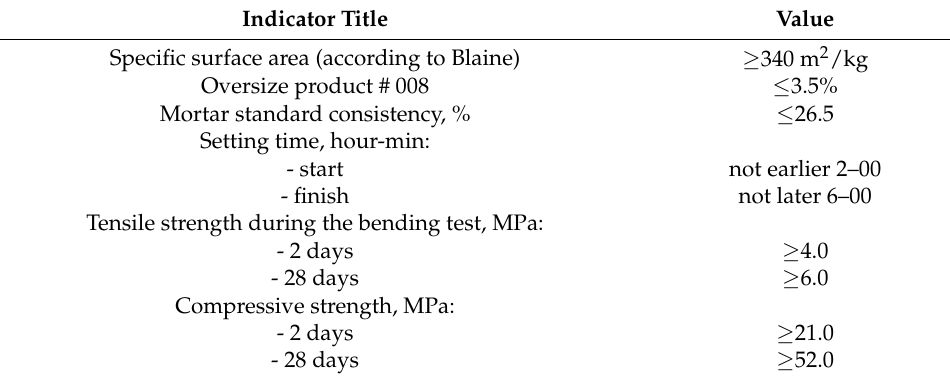
Table 1. Characteristics of Portland cement PC500 D0.